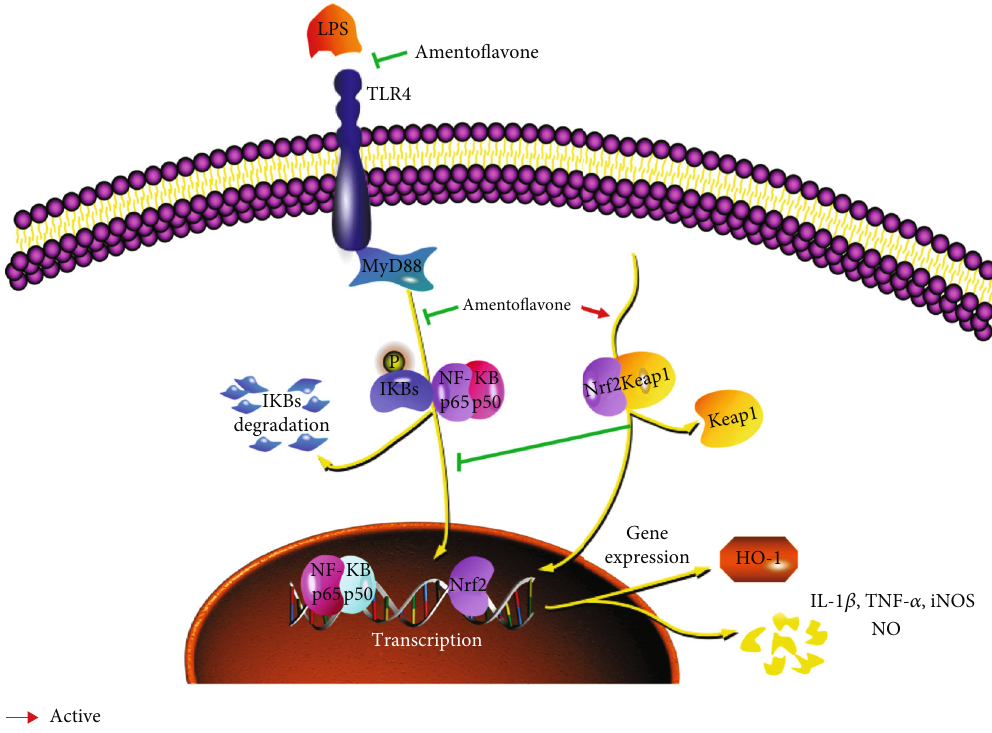
Figure 6: A schematic of a putative mechanism of amento fl avone in the progressive of neuroin fl ammation-related diseases. In this model, amento fl avone inhibits the TLR4/MyD88/NF- κ B and activating Nrf2/HO-1